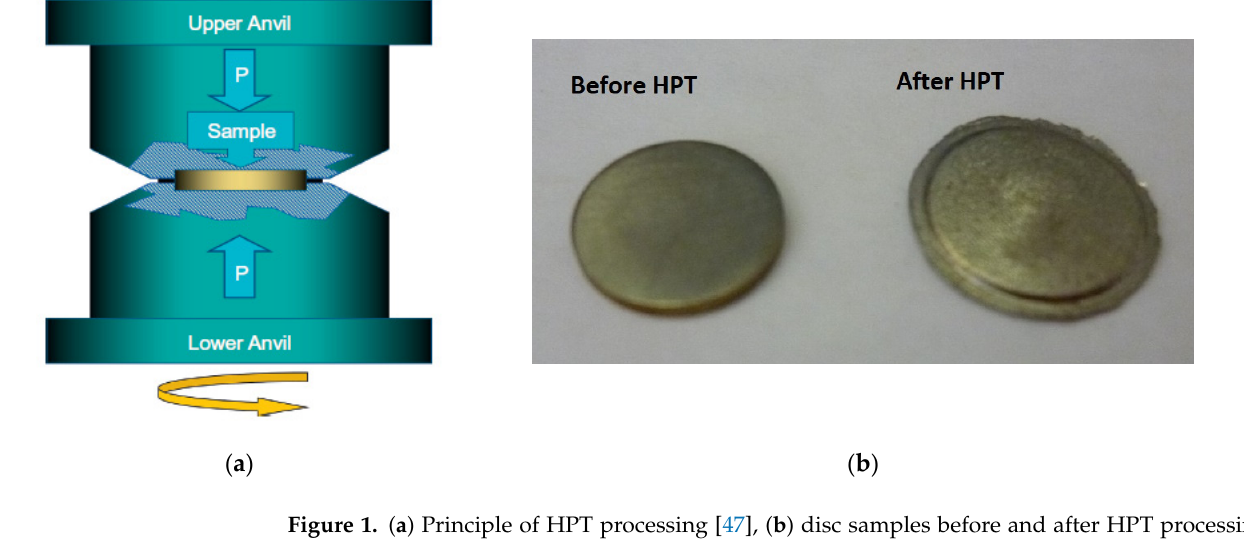
Figure 1. ( a ) Principle of HPT processing [47], ( b ) disc samples before and after HPT processing. Reprinted with permission from ref. [47]. Copyright 2022 Elsevier.